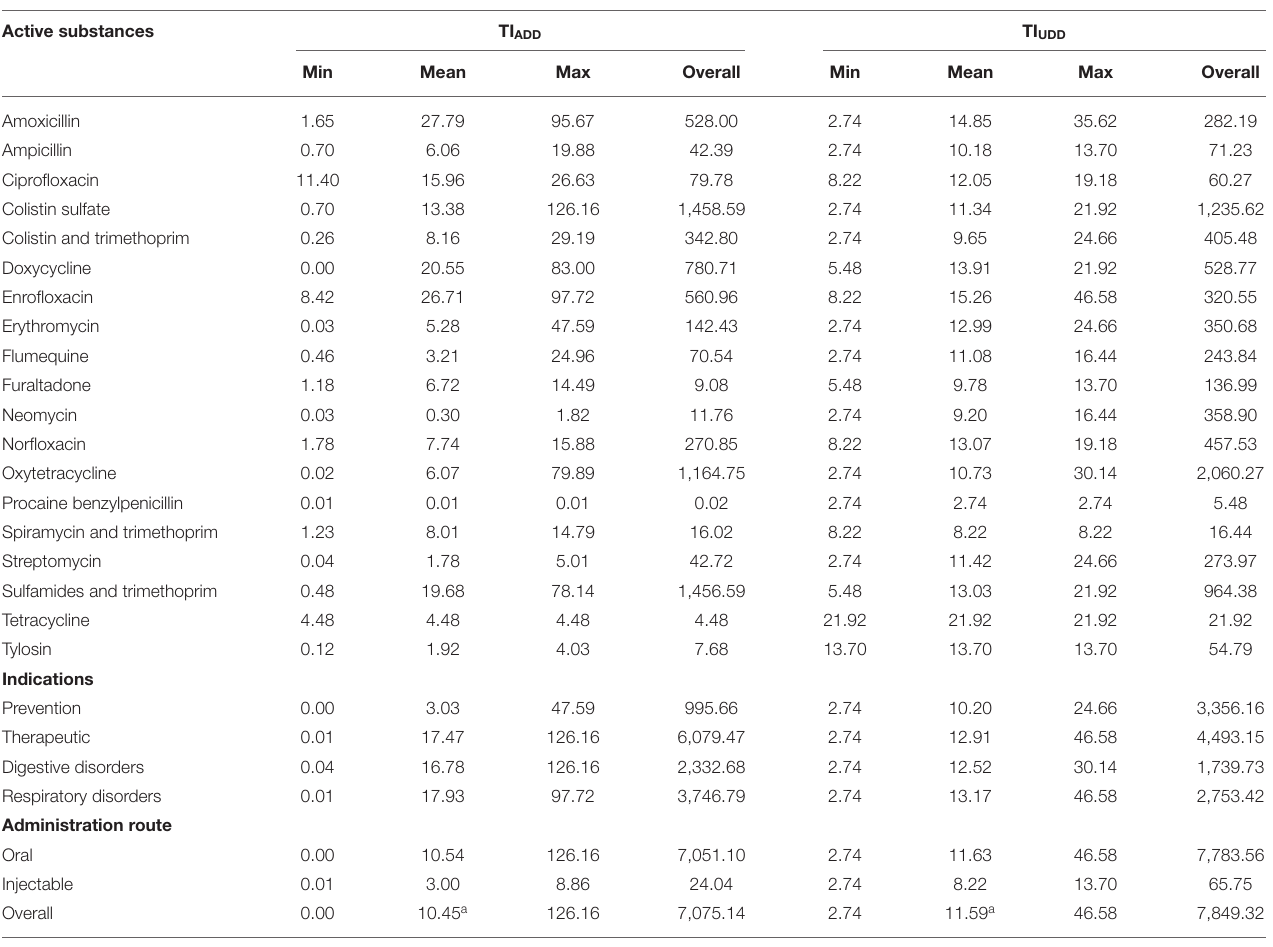
TABLE 5 | Distribution of treatment incidence according to the active substances, indications, and administration routes for poultry farming in the West Region of Cameroon between January and December